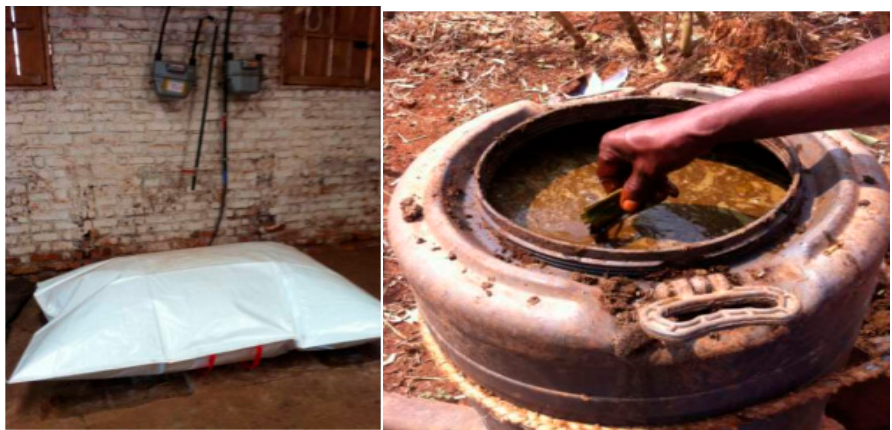
Figure 6. Biogas production process using cow dung at the Faculty of Agriculture, UEA, eastern DRC.